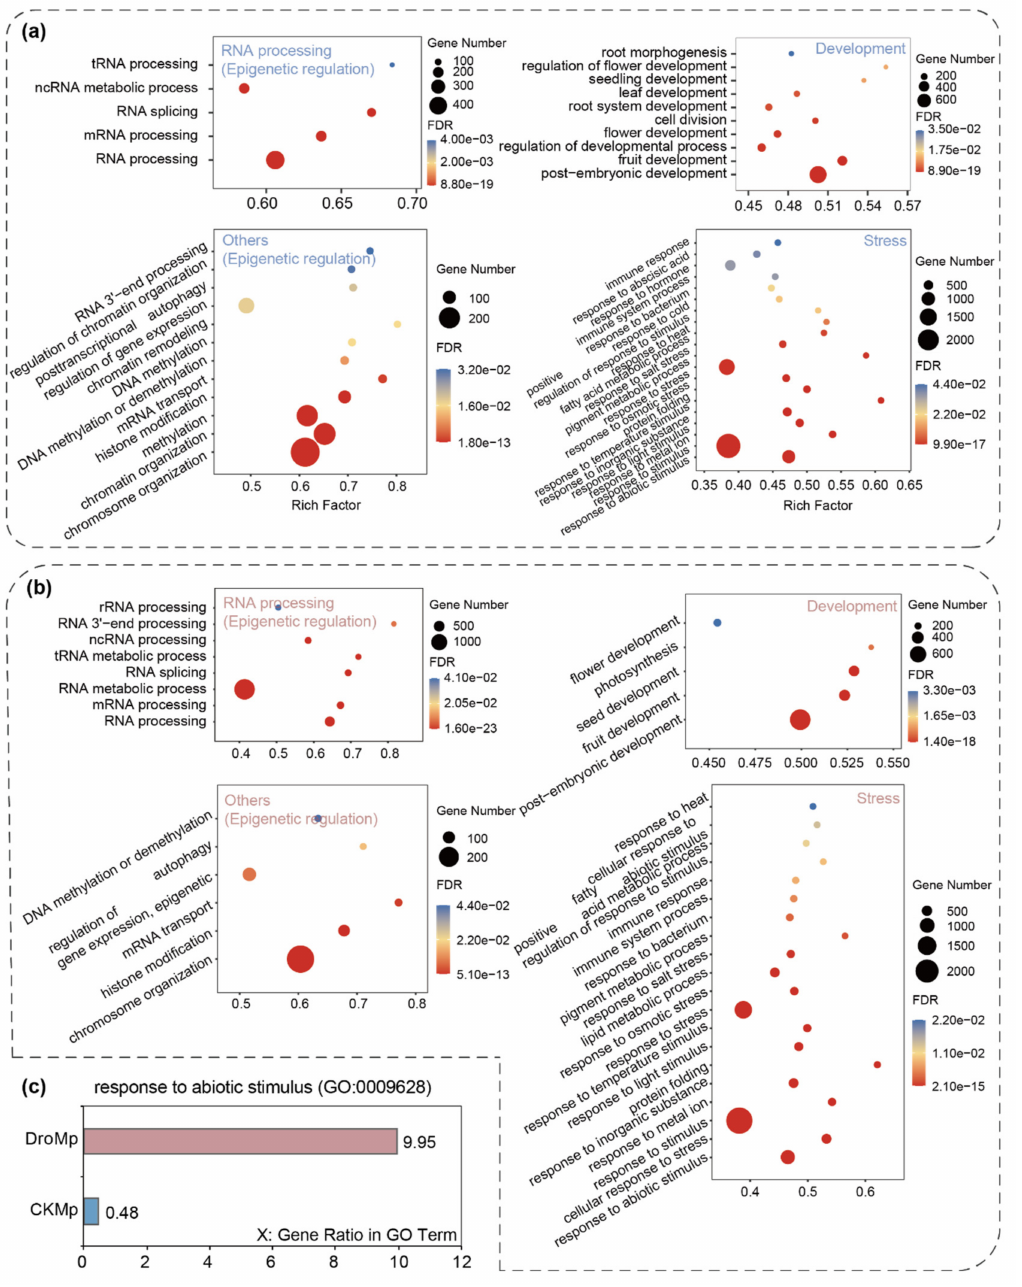
Figure 2. Gene ontology (GO) enrichment analysis of m 6 A-modified genes in Malus prunifolia seedlings in response to drought. ( a , b ) The “biological process” aspect of the GO enrichment analysis was divided into “RNA processing (epigenetic regulation)”, “others (epigenetic regulation)”, “development”, and “stress”. ( c ) The gene ratio of “response to abiotic stimulus (GO:0009628)” in Malus prunifolia seedlings in response to drought conditions. DroMp, M. prunifolia seedlings were treated with drought stress; CKMp, M. prunifolia seedlings were grown under control condition; FDR, false discovery